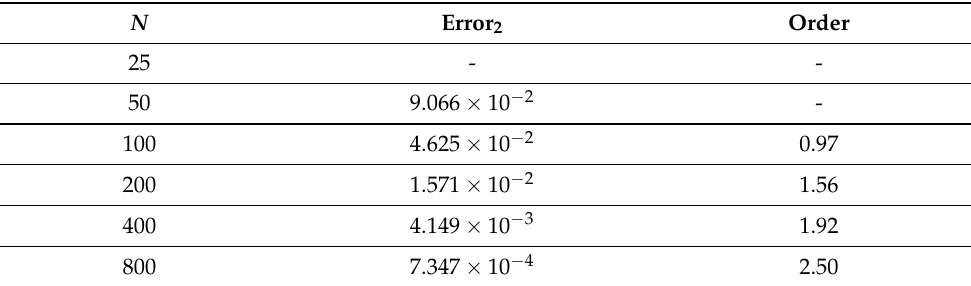
Table 3. Accuracy test of the C system (3) and (4): we show the L 2 -norm of the relative error for | C | , with the parameters defined in T EST